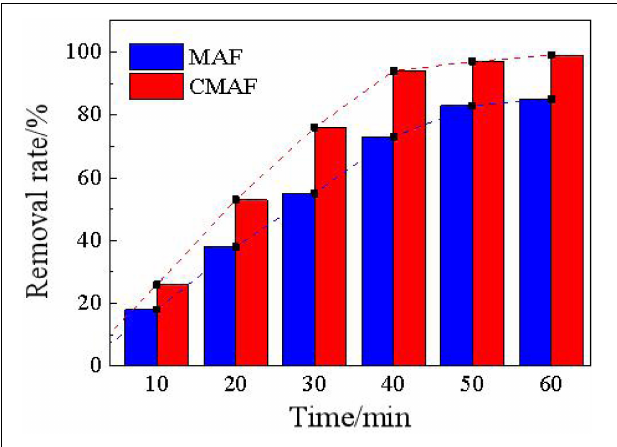
FIGURE 15 | Comparison diagram of the removal